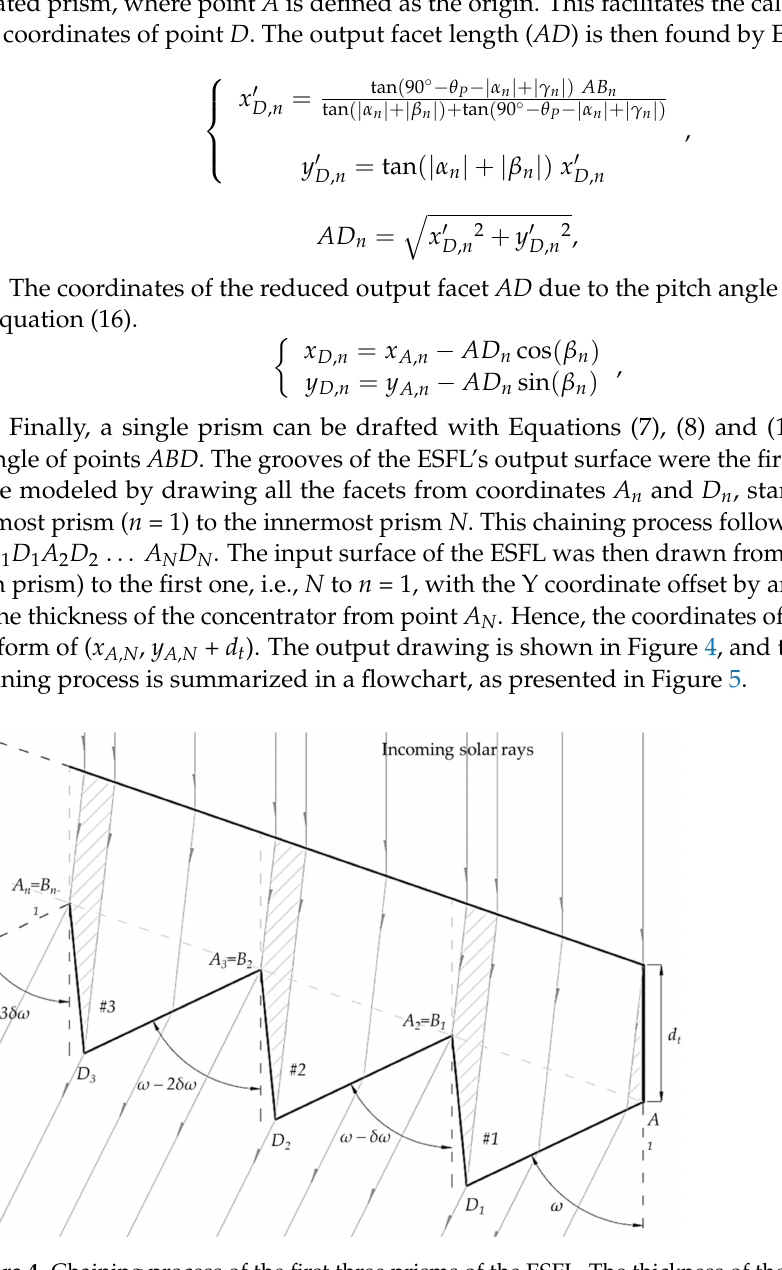
Figure 4. Chaining process of the first three prisms of the ESFL. The thickness of the concentrator is attributed by offsetting the input facet by d t from its original coordinate